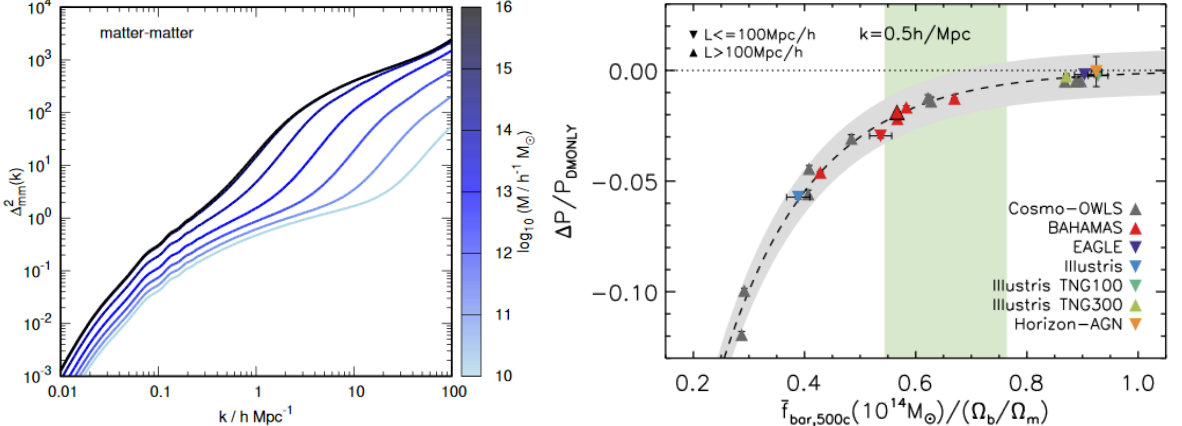
Figure 16. ( Left ) The contribution to the dimensionless matter power spectrum for halos of different mass. The curves show the resulting power spectrum when integrated up to different choices of the maximum halo mass. Here we can see that halos corresponding to galaxy groups (10 13 − 14 M ) contribute a very large fraction of the power over the range of wavenumbers (cid:12) probed by LSS measurements (typically k (cid:46) 10 h Mpc − 1 ). This figure was reproduced with permission from Mead et al. [338]. ( Right ) The effect of galaxy formation on the matter power spectrum at the scale k = 0.5 h Mpc − 1 as a function of the mean normalized baryon fraction in 10 14 M halos. Shown are simulations from cosmo-OWLS and BAHAMAS (grey and red), ∼ (cid:12) EAGLE (purple), Illustris (blue), TNG100 and TNG300 (cyan and green) and Horizon-AGN (orange). Baryon fractions were calculated within r 500 c for halos in the mass range M 500 c = [ 6 10 13 ,2 10 14 ] M . The dashed curve shows that at this k , × × (cid:12) a simple exponential function of the baryon fraction fits the predictions for the suppression of power of all simulations to within 1% (grey band). The vertical green band shows a range of mean group-scale baryon fractions roughly consistent with observations. These results demonstrate that the differences in the simulation predictions for the impact of baryons on P ( k ) can be understood to high accuracy based on differences in the baryon fraction on the group scale and that calibration to observed baryon fractions is a promising tool for constraining feedback processes in the simulations. This figure was reproduced with permission from van Daalen et al.